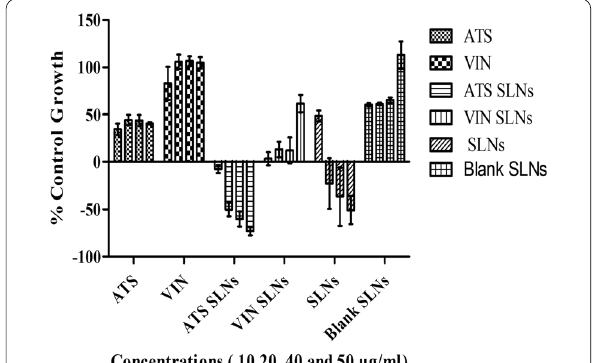
Fig. 6 Growth curve: human hepatoma Hep-G2 cell line